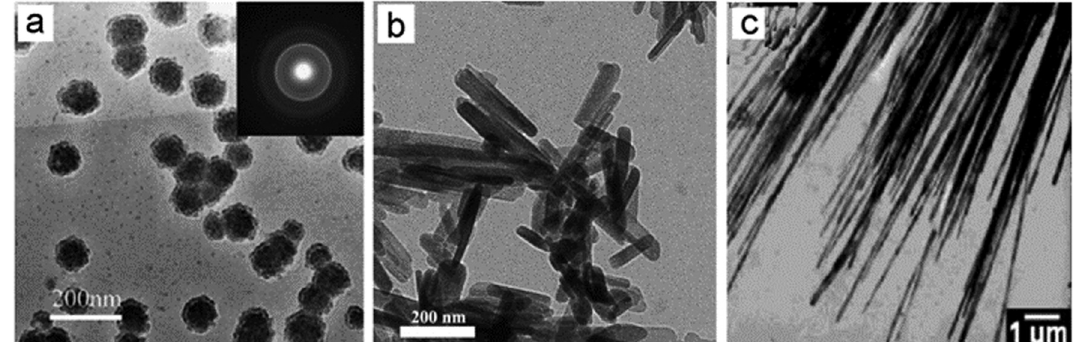
Figure 1: ( a ) Spherical nano - HA particles, particle size is about 80 nm; ( b ) rod - like nano - HA particles, particle diameter is about 60 nm; ( c ) needle - like nano - HA particles, particle diameter ranged from 50 to 70 nm [ 7,9 ]